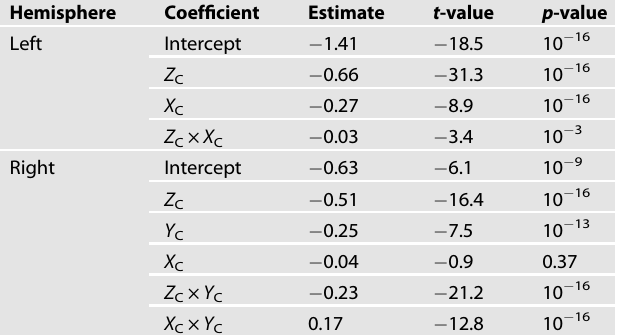
Fig. 5 Association between clinical outcome and lesion location along the ventral to dorsal (V – D) axis of the ALIC. A Each point represents a lesioned voxel in the left hemisphere, arranged by location along the ventral-to-dorsal ( z -) axis (value is mm from the AC-PC plane). Dashed line is the linear fi t between the slice location and the Y-BOCS residual change score (negative values indicate better than average reduction and are plotted “ up ” ; positive values indicate worse than average reduction). The horizontal line at 0 indicates average Y-BOCS reduction following surgery. Only voxels lesioned in at least three patients are included. Absolute value of the correlation shows the linear relationship between the z -axis location and the Y-BOCS residual. B The same data for the right hemisphere lesioned voxels. Table 1. Best fi tting coef fi cients for multiple linear regression models ( fi t separately for left and right hemispheres) relating Y-BOCS residual to spatial location, with signi fi cant results included in the